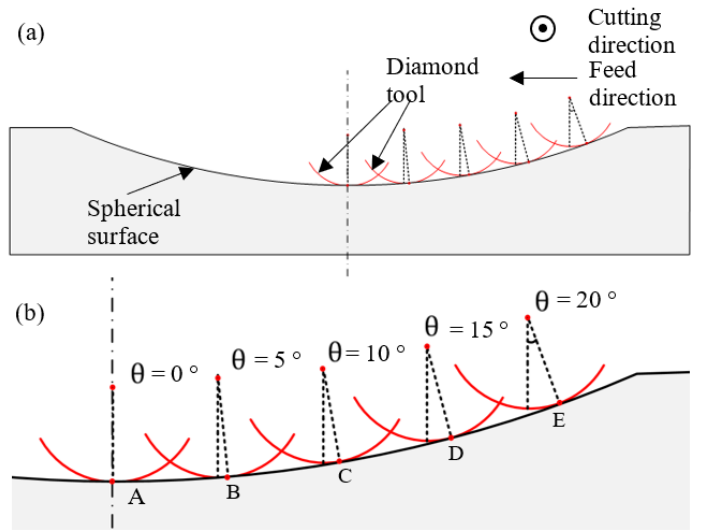
Figure 5. ( a ) Schematic diagram of cutting a concave spherical mould. ( b ) A partial enlarged view of ( a